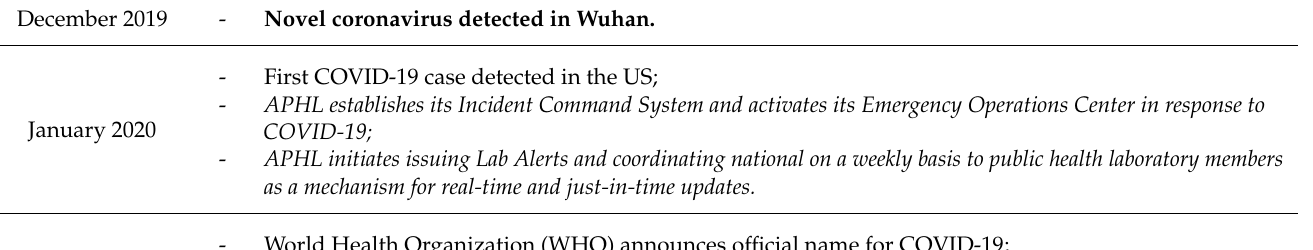
Table 1. COVID-19 history and newborn screening impact